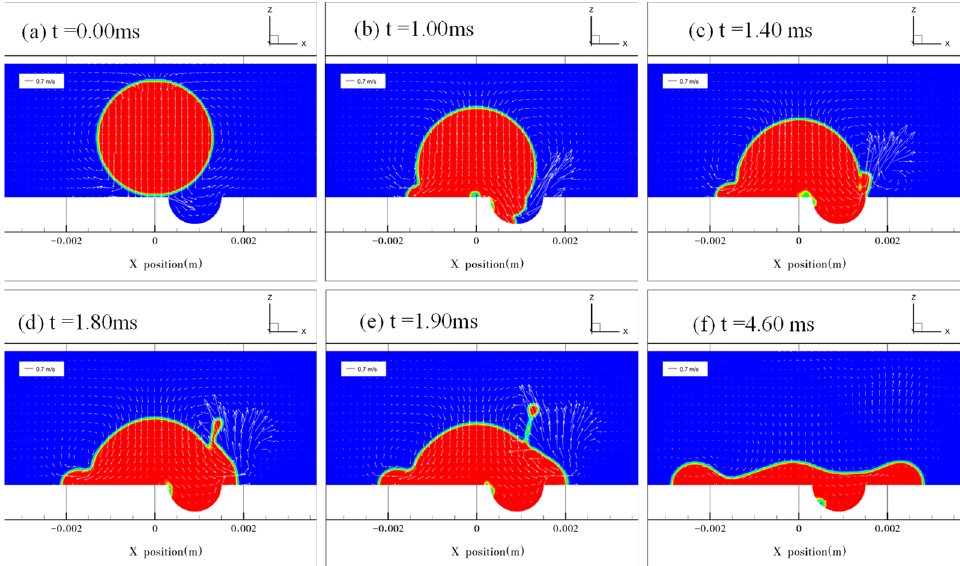
Figure 8. Droplet impacting the dimpled surface at e = 0.75. ( a ) The droplet starts to impact the surface when t = 0.00 ms. ( b ) The edge of the droplet advances along the dimpled surface. ( c ) The droplet blankets the dimple. Jetting is formed on the right side of the droplet. ( d ) The jetting position shifts up along the droplet’s surface because of the inertia force. ( e ) The breakup of the jet for the formation of satellite droplets. ( f ) The droplet reaches its maximum spreading diameter.